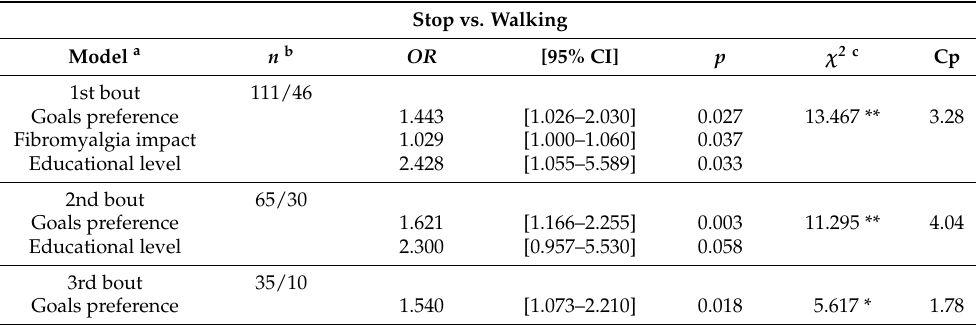
Table 2. Logistic regression analyses.